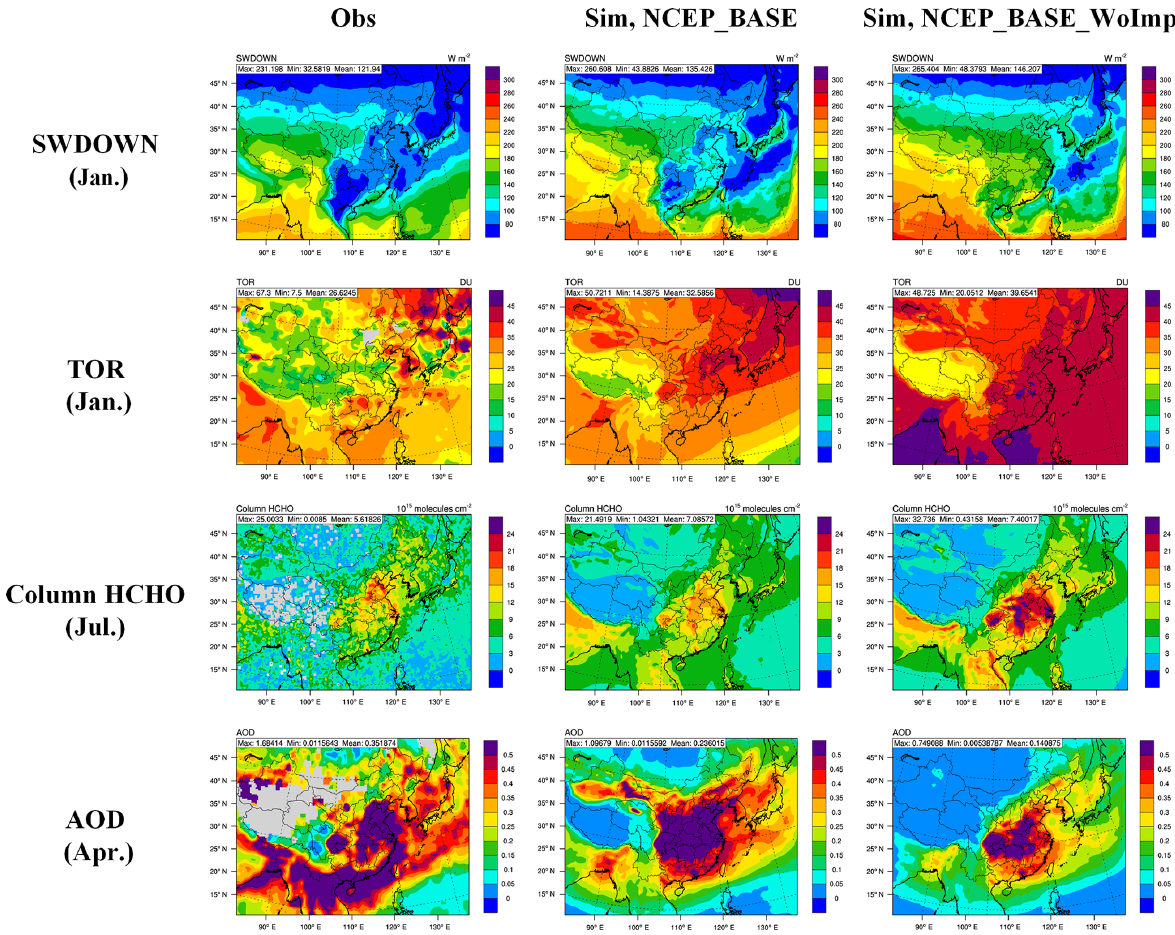
Figure 10. Comparison of spatial distributions of SWDOWN in January, TOR in January, column HCHO in July, and AOD in April 2013 from (a) satellite observations, (b) baseline simulation (NCEP_BASE – with aerosol feedbacks, using CESM-derived BCs, BEIS3 emissions, and revised dust scheme), and (c) sensitivity simulation (NCEP_BASE_WoImp – without aerosol feedbacks, using fixed BCs, MEGAN2 emissions, and default dust scheme).